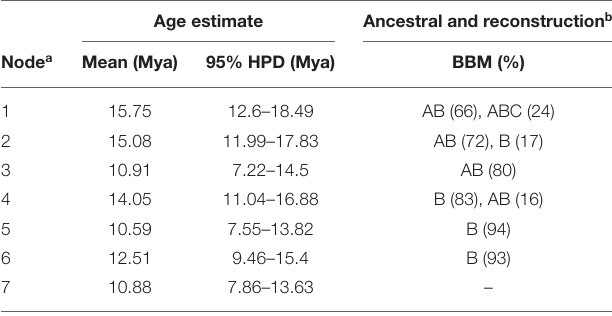
Age estimate Ancestral and reconstruction